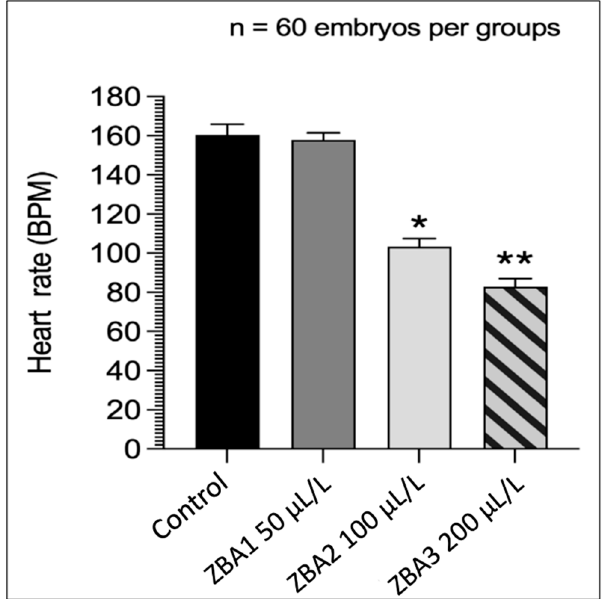
Figure 3. Anesthetic trials. Heartbeat in zebrafish embryos at 96 hpf. Significant difference among groups: * ZBA2 vs. CTRL and ZBA1 groups; ** ZBA3 vs. CTRL, ZBA1, and ZBA2 groups. Values are expressed as mean ± SD of three independent experiments ( n = 60 embryos); * p < 0.0001 when compared to the control group.